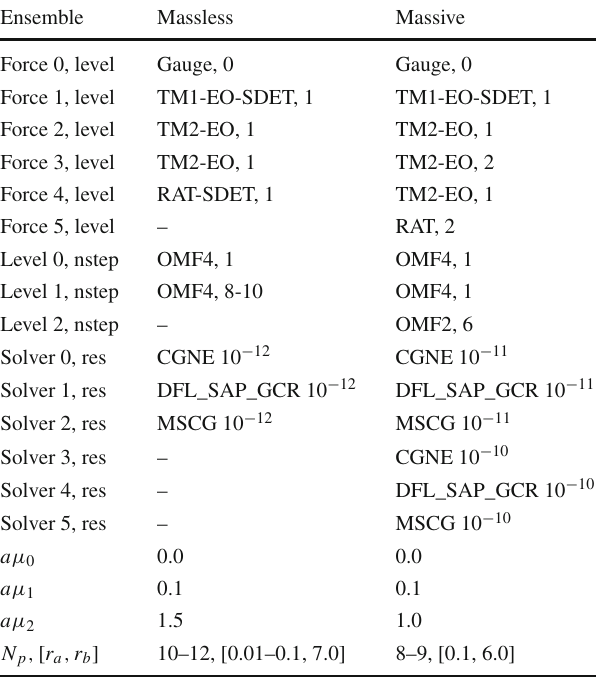
Table 11 Parameters of the algorithm: We give the forces with their integration levels, the integrators for the different levels and number of steps (nstep) per trajectory resp. outer level, the solvers for the various levels and their residue, the twisted-mass parameters a μ i , the number of poles N p and the ranges [ r a , r b ] used in the RHMC. For the force and